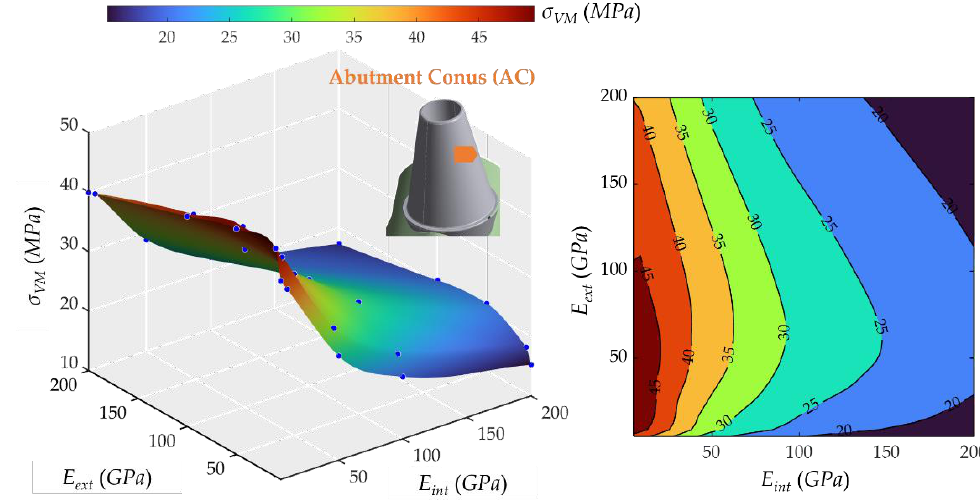
Figure 7. Von Mises maximum stress in the conic surface of the abutment, abutment cone (AC). ( Left ): 3D representation. ( Right ): vertical projection.